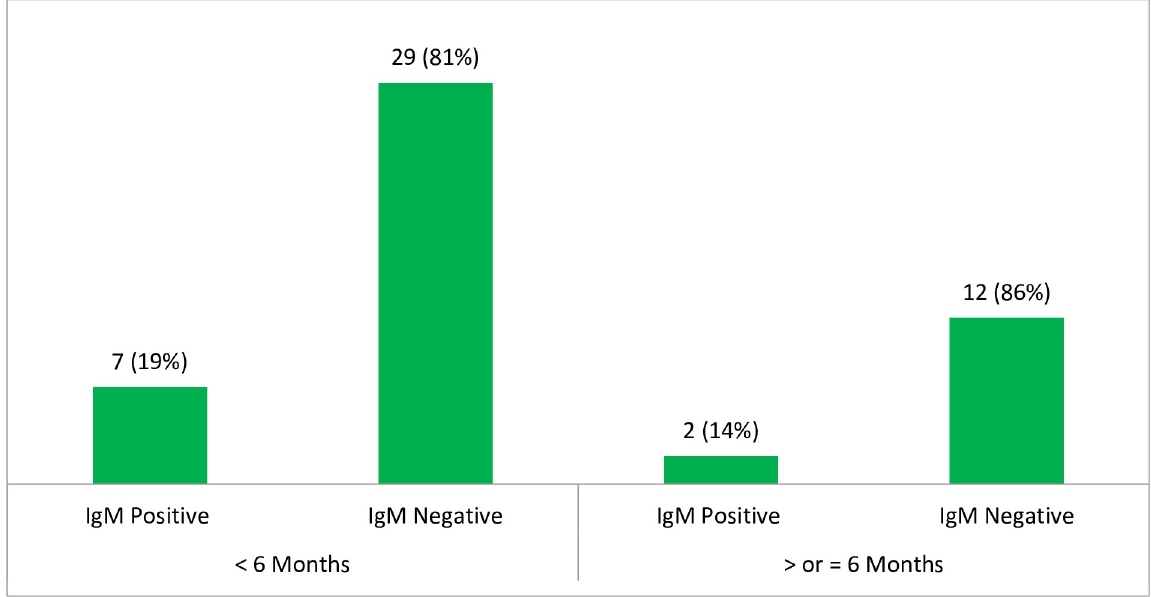
Fig 3. Rubella specific IgM positivity rate in the different age categories of infants suspected for CRS in Amhara Regional State Referral Hospitals, Northwest Ethiopia, December 2015-August 2017.